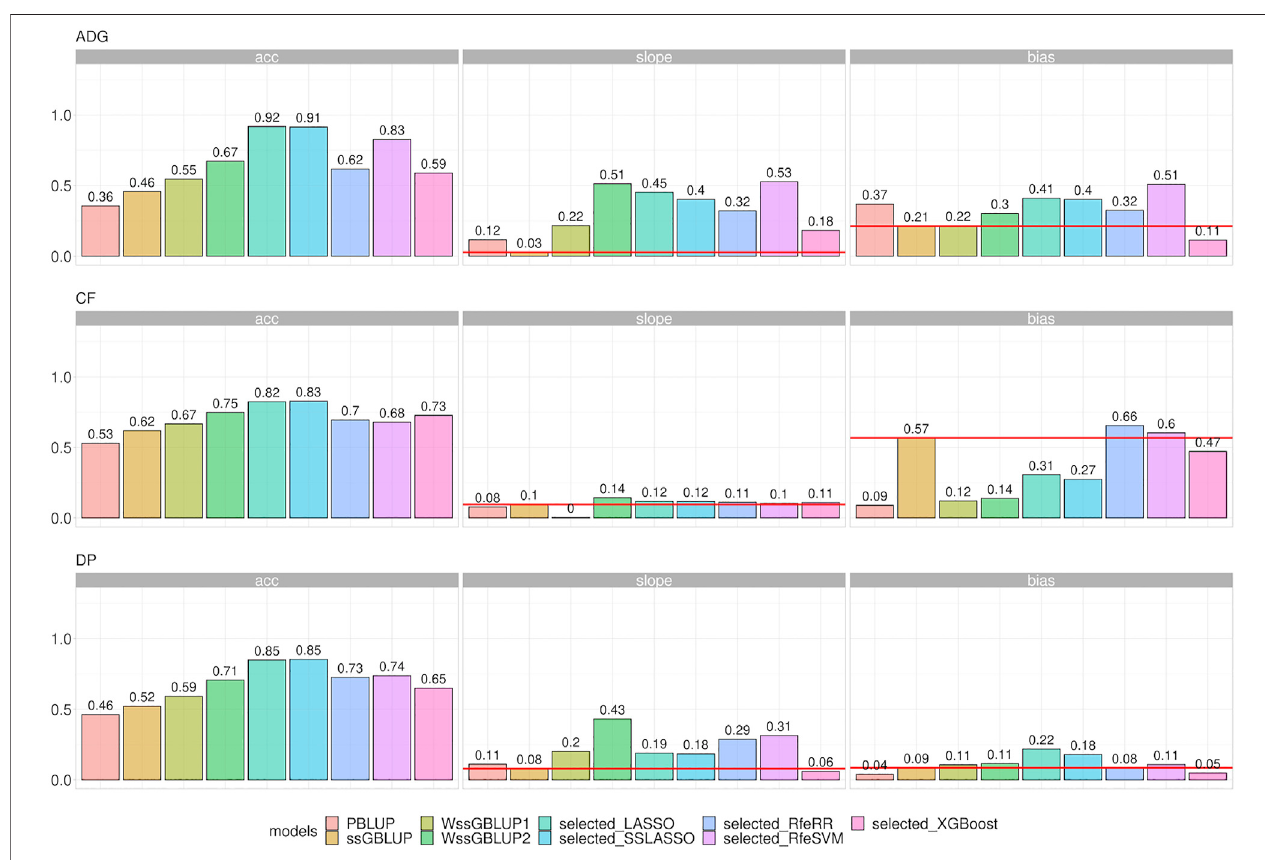
FIGURE 8 | Bar plots representing accuracy, dispersion, and bias of the Rendena data set estimated using LR cross-validation in the validation cohort of 2015 – 2020.Dispersionwasde fi nedas1,theabsolutevalueofdispersion,whilebiasasabsolutevaluesofbiasdividedbyitsgeneticvariancetoimproveassessmentof model rankings. Horizontal lines represent the values of ssGBLUP to permit easier comparison among